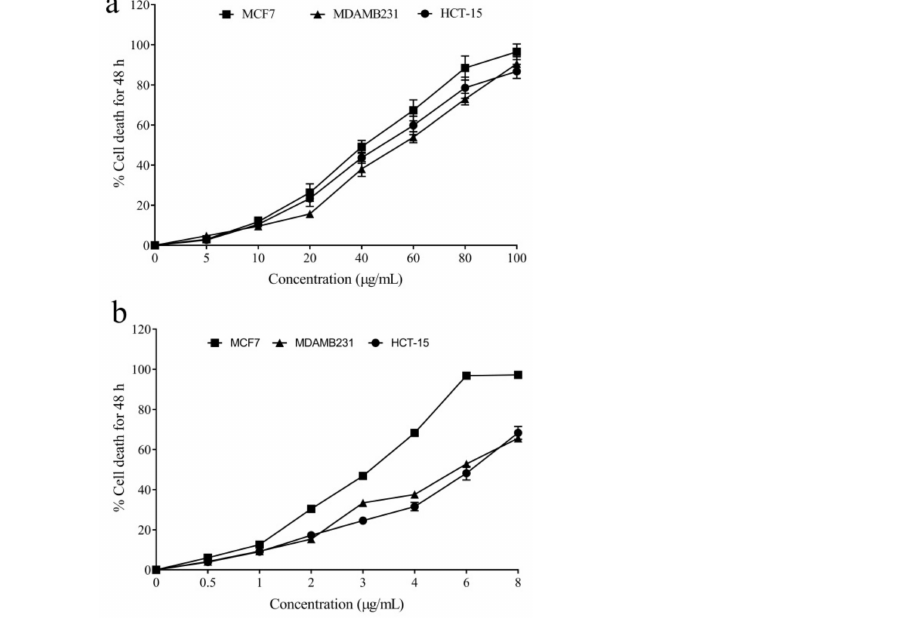
Figure 2. The anticancer potentials of the leaf extract of A. nilagirica ( a ) and cyclophosphamide ( b